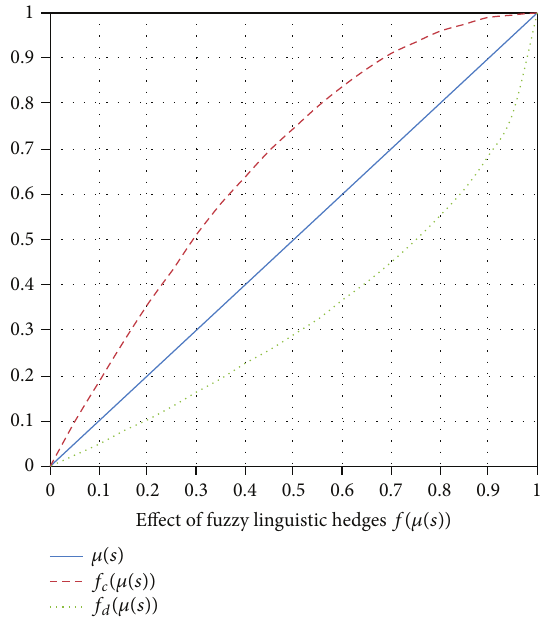
Figure 2: Depiction of linguistic